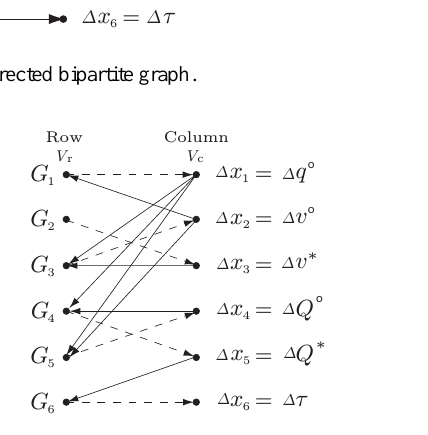
Figure 6. Perfect